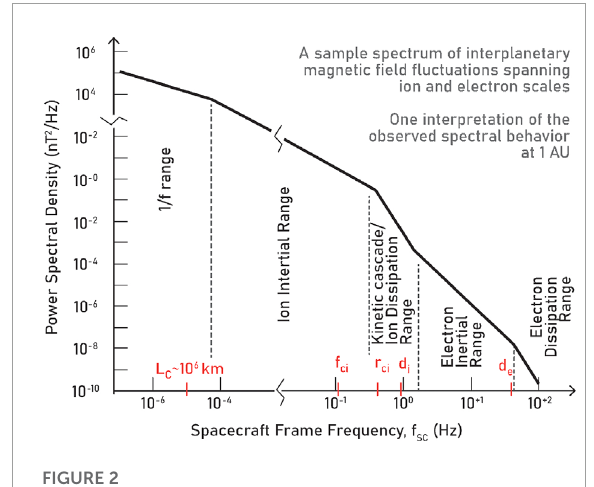
FIGURE 2 Scheme of the magnetic power spectrum of SW turbulence at 1 AU. The correlation scale ( L C ) , proton gyrofrequency ( f ci ) , proton Larmor radius ( r ci ) and the proton and electron inertial lengths ( d i and d e , respectively) derived from the Doppler-shift relation are also shown. Reproduced from Fraternale et al.